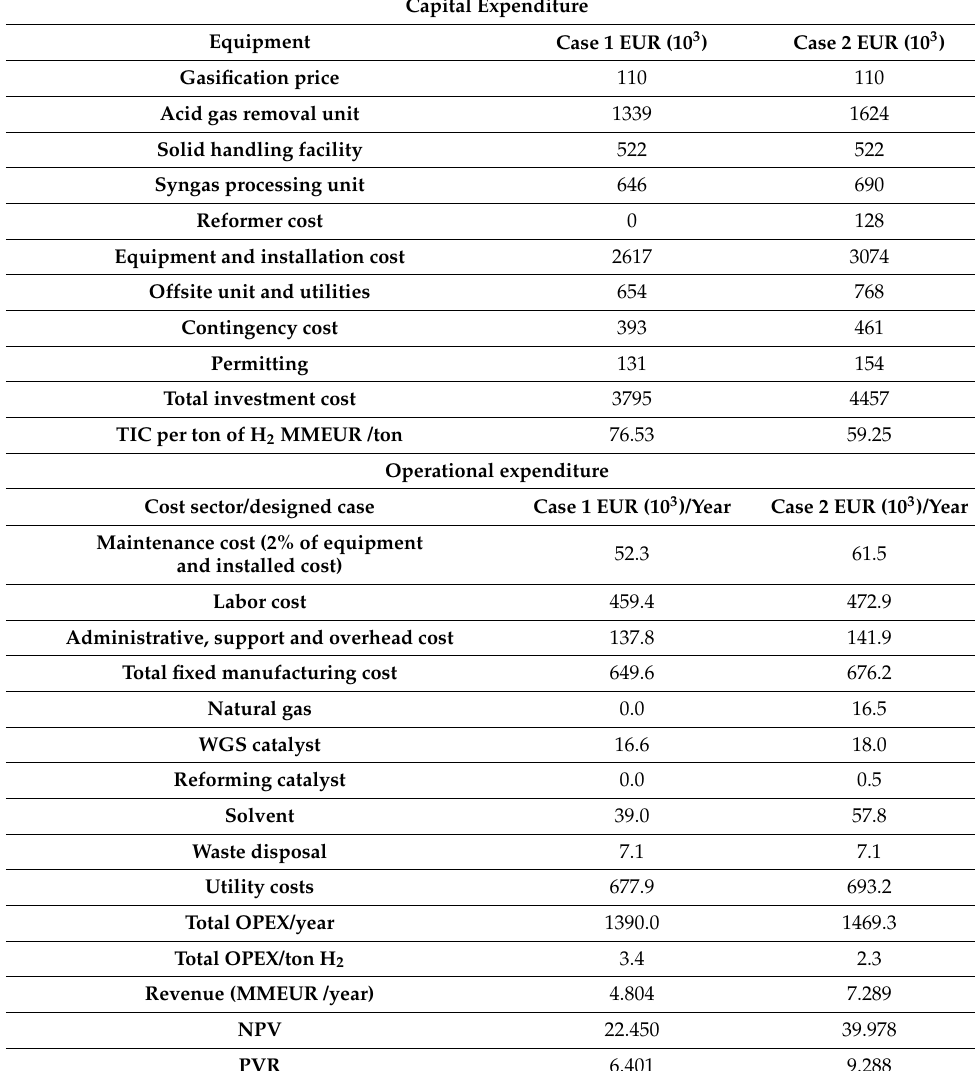
Table 6. CAPEX and OPEX for case 1 and case